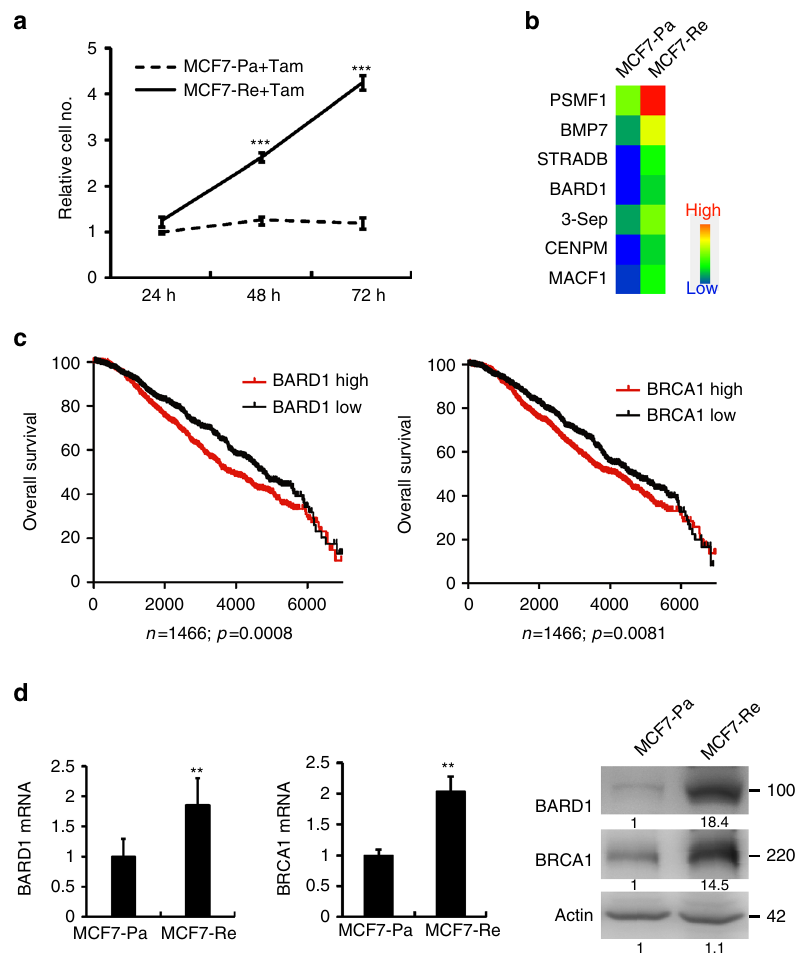
Fig. 1 BARD1/BRCA1 is upregulated in tamoxifen-resistant breast cancer cells. a The growth curve of MCF7-Pa and MCF7-Re cells under tamoxifen treatment. b mRNA expression pro fi le analysis shows upregulated proliferation-related genes in MCF7-Re cells. c Kaplan – Meier survival curves of breast cancer patients with low (black) and high (red) BARD1 or BRCA1 expression based on Curtis data set. d The mRNA and protein expression of BARD1 and BRCA1 in MCF7-Pa and MCF7-Re breast cancer cells. In a , d , data show means ± s.d. ( n = 3) ** p < 0.01; *** p < 0.001 compared with MCF7-Pa by Student ’ s t